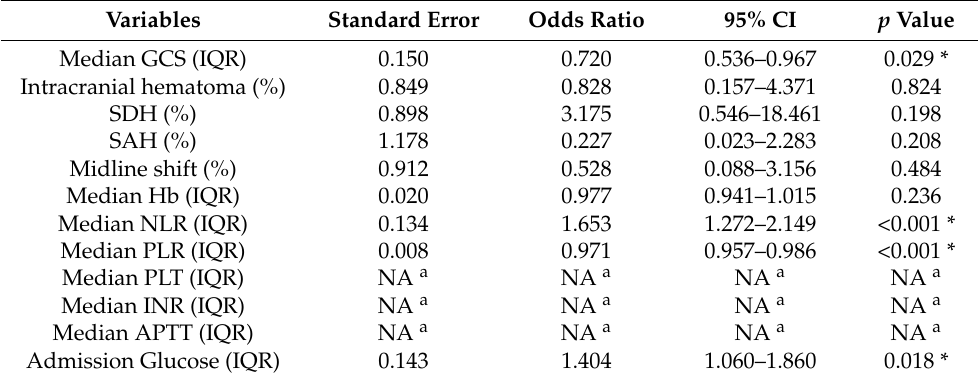
Table 2. Multivariate logistic regression analysis for patients with coagulopathy.